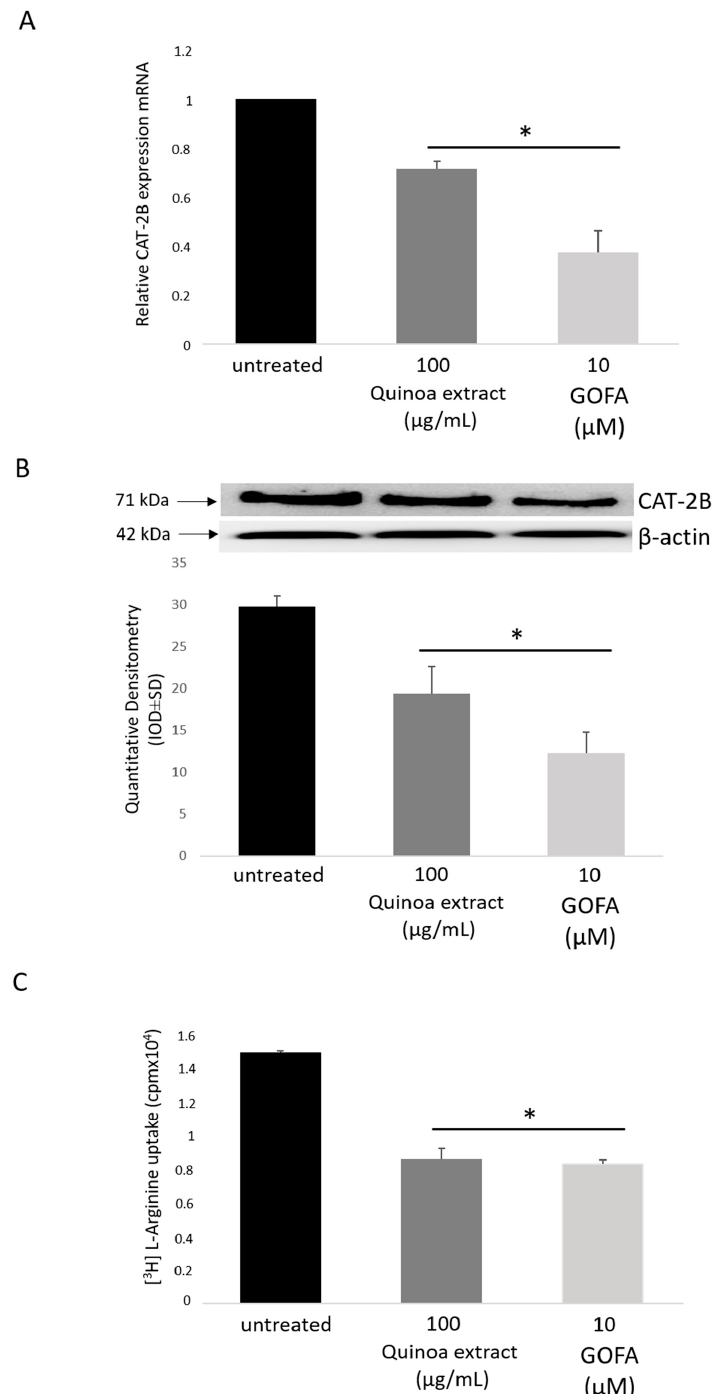
Figure 4. The effect of quinoa extract and GOFA on L-arginine transport in HCT116 cells. ( A ) mRNA expression of the CAT-2B. ( B ) Representative Western blot and densitometric analysis of CAT-2B expression. ( C ) ( 3 H) l -arginine uptake. Data are expressed as the mean ± SD. * p < 0.05 vs. untreated